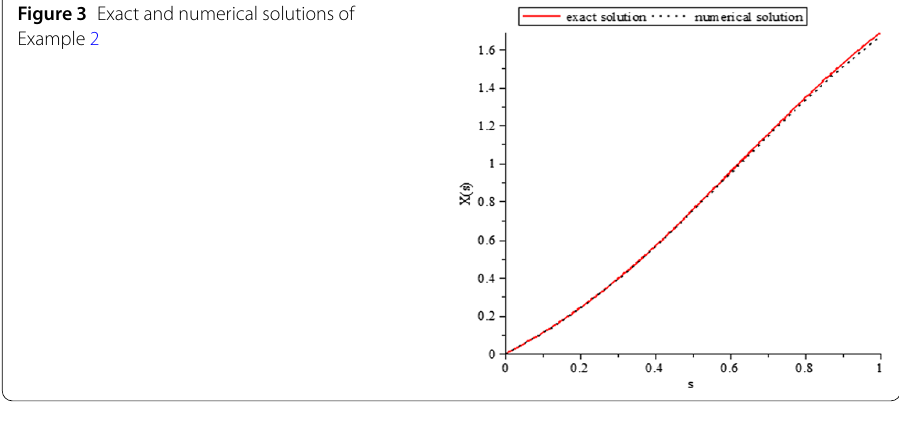
Figure 3 Exact and numerical solutions of Example